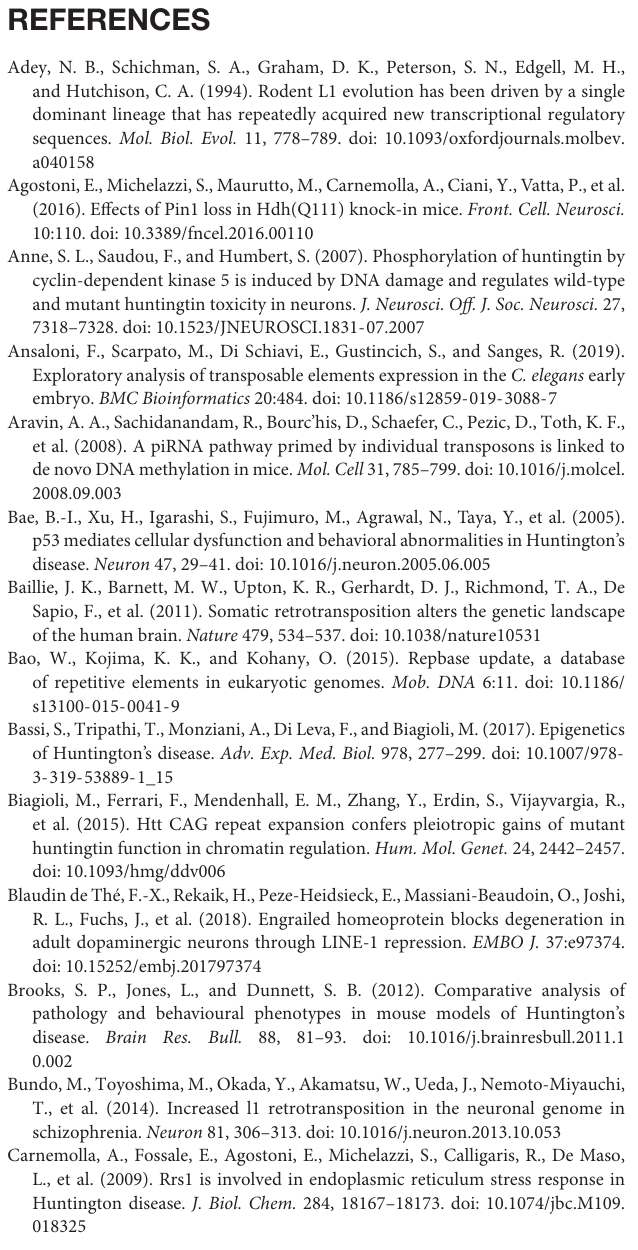
metadata for the Q111 vs. Q20 comparison in the striatum of 10 month-old mice are reported. Supplementary Table 3 | Differentially expressed TEs in mouse striatum—Q175 vs. Q20–6 month-old. TE name, log2 fold-change, FDR-corrected p -value and metadata for the Q175 vs. Q20 comparison in the striatum of 6 month-old mice are reported. Supplementary Table 4 | Differentially expressed TEs in mouse striatum—Q175 vs. Q20–10 month-old. TE name, log2 fold-change, FDR-corrected p -value